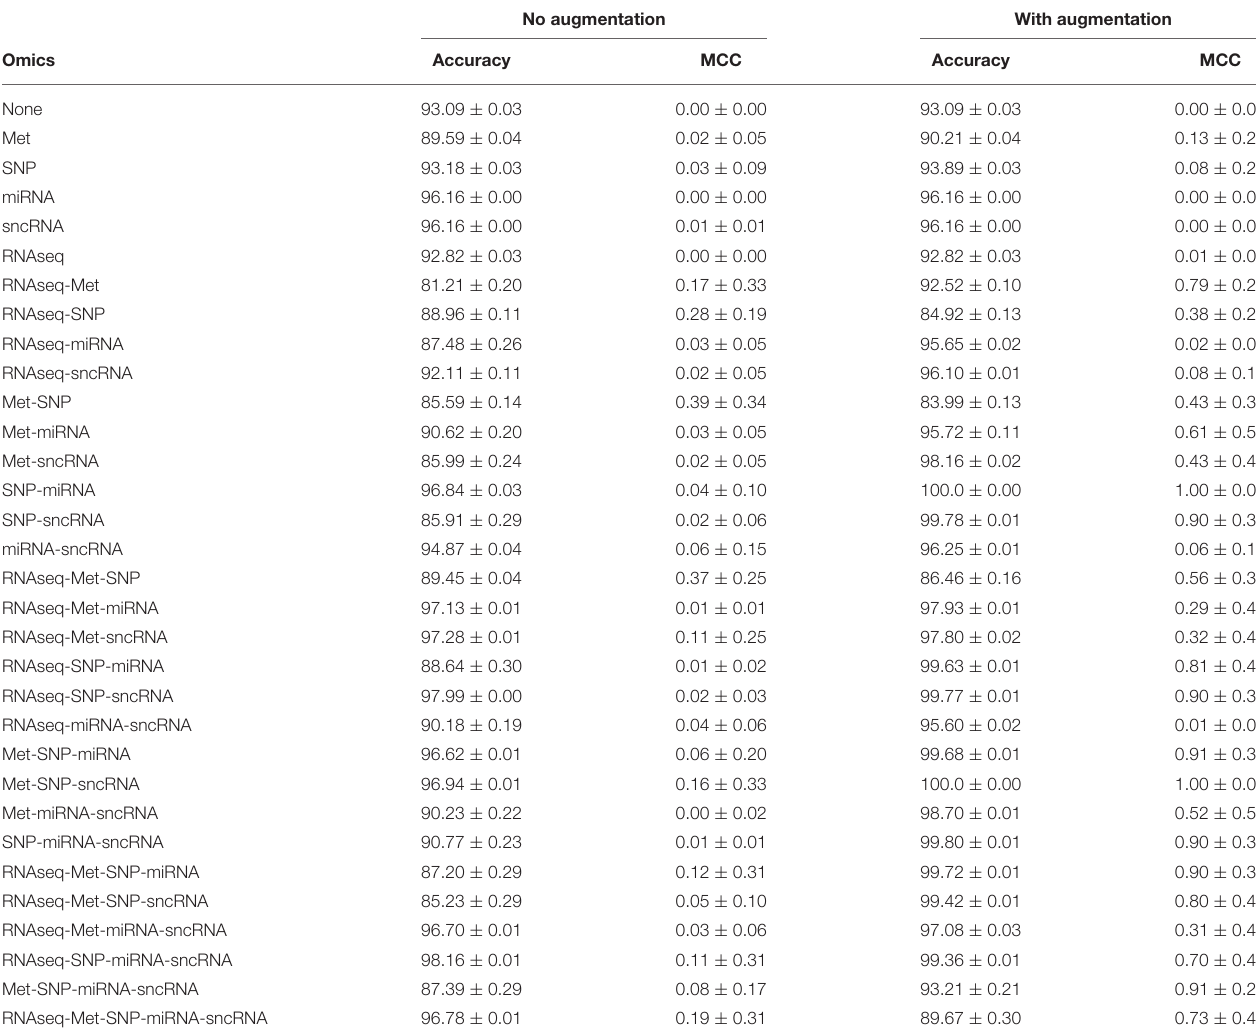
TABLE 4 | Comparison of model performance on DTI-fMRI data, with and without training set